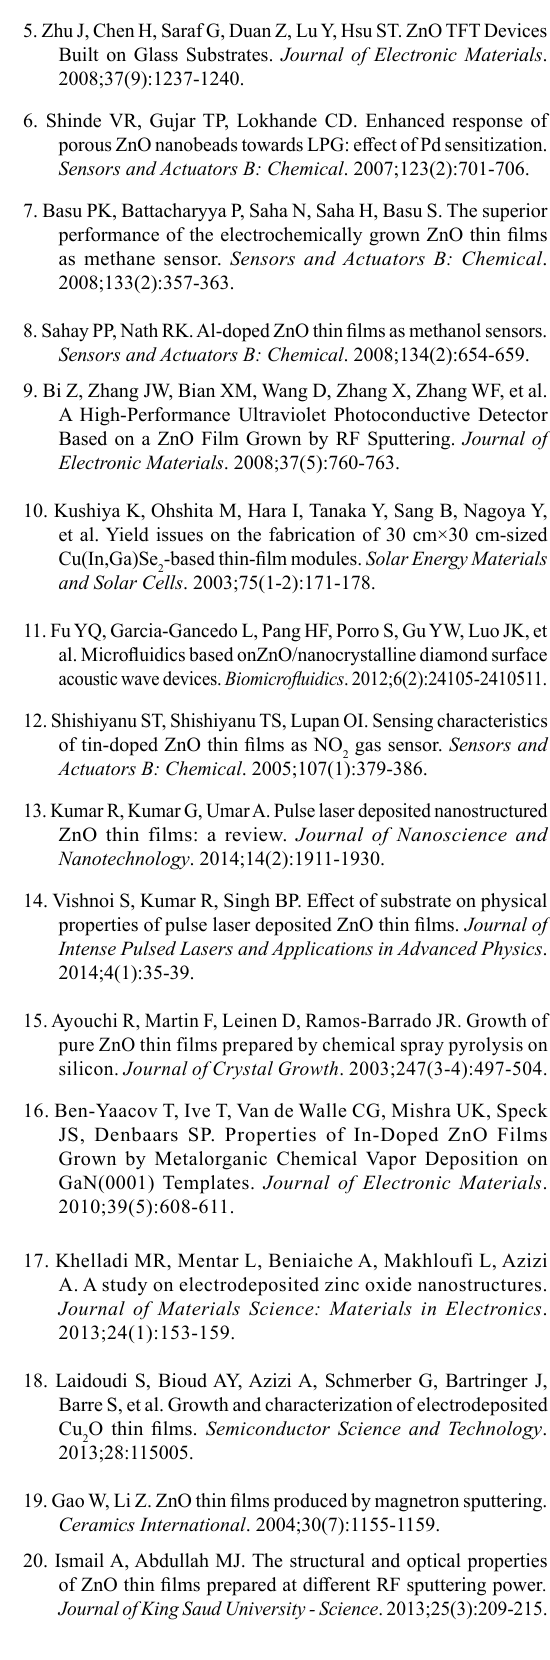
Figure 5: PL spectra of ZnO thin films on Si substrate versus wavelength with different oxygen flow.